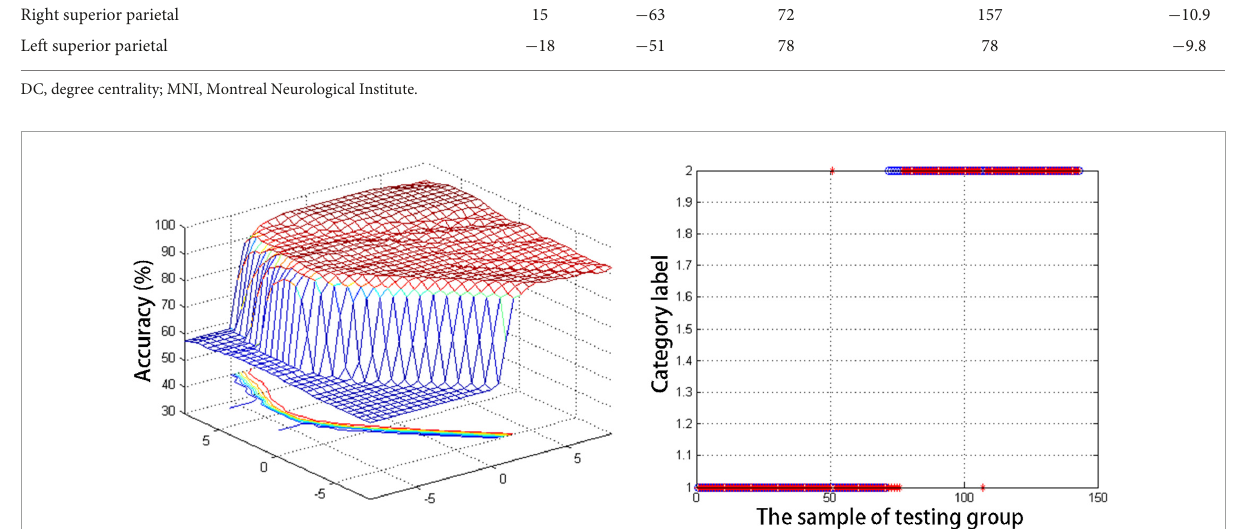
FIGURE2 The general information of support vector machine results for discriminating adolescent depression patients and